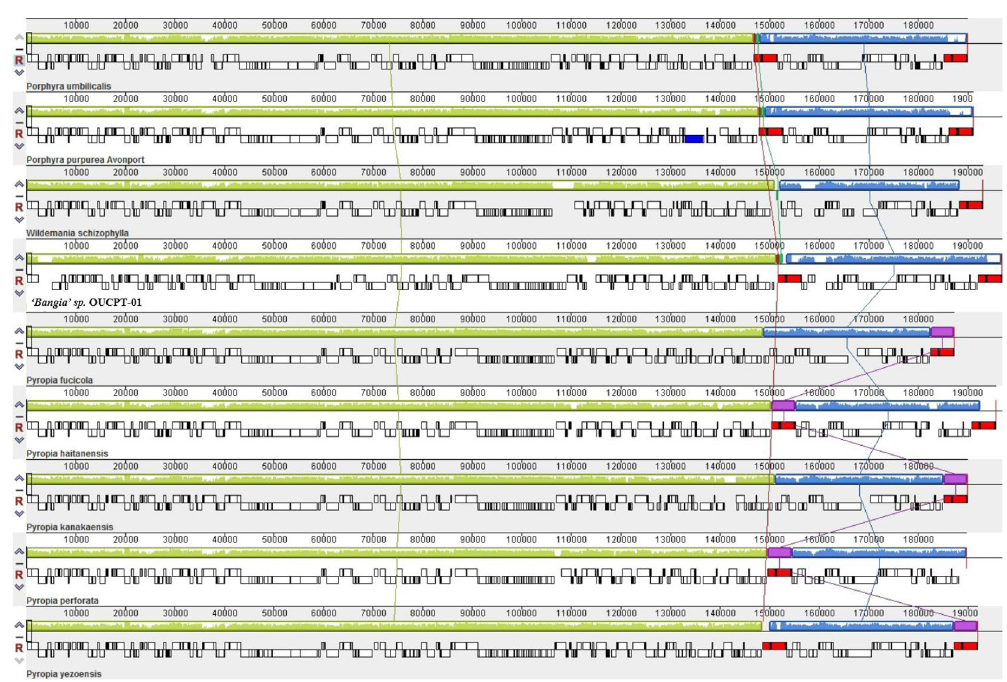
Figure 4. Genome comparison among Bangiophyceae plastid genomes. Two of the nine plastomes were highly co-linear. Py. perforata had one region representing ribosomal 23S, 16S, and 5S whereas the other species had two repeat regions (red